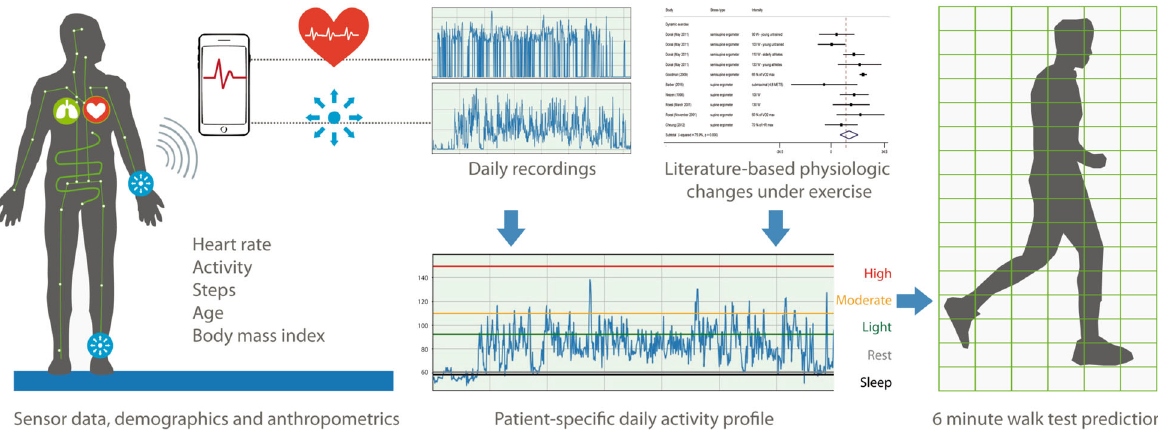
Fig. 5 Graphical summary. Step-by-step presentation of the concept for predicting 6-minute walk distances based on daily recordings from wrist-worn devices in combination with demographic and anthropometric